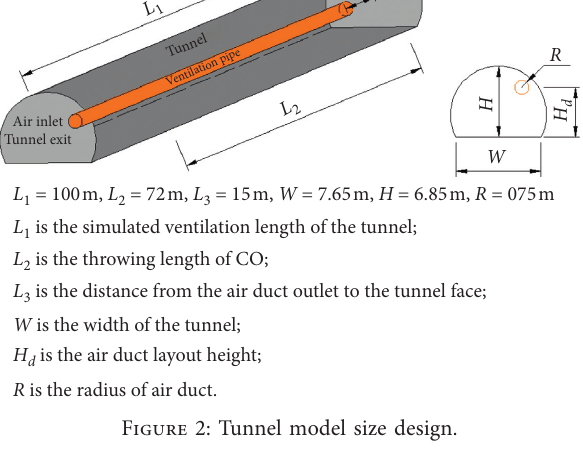
Figure 2: Tunnel model size